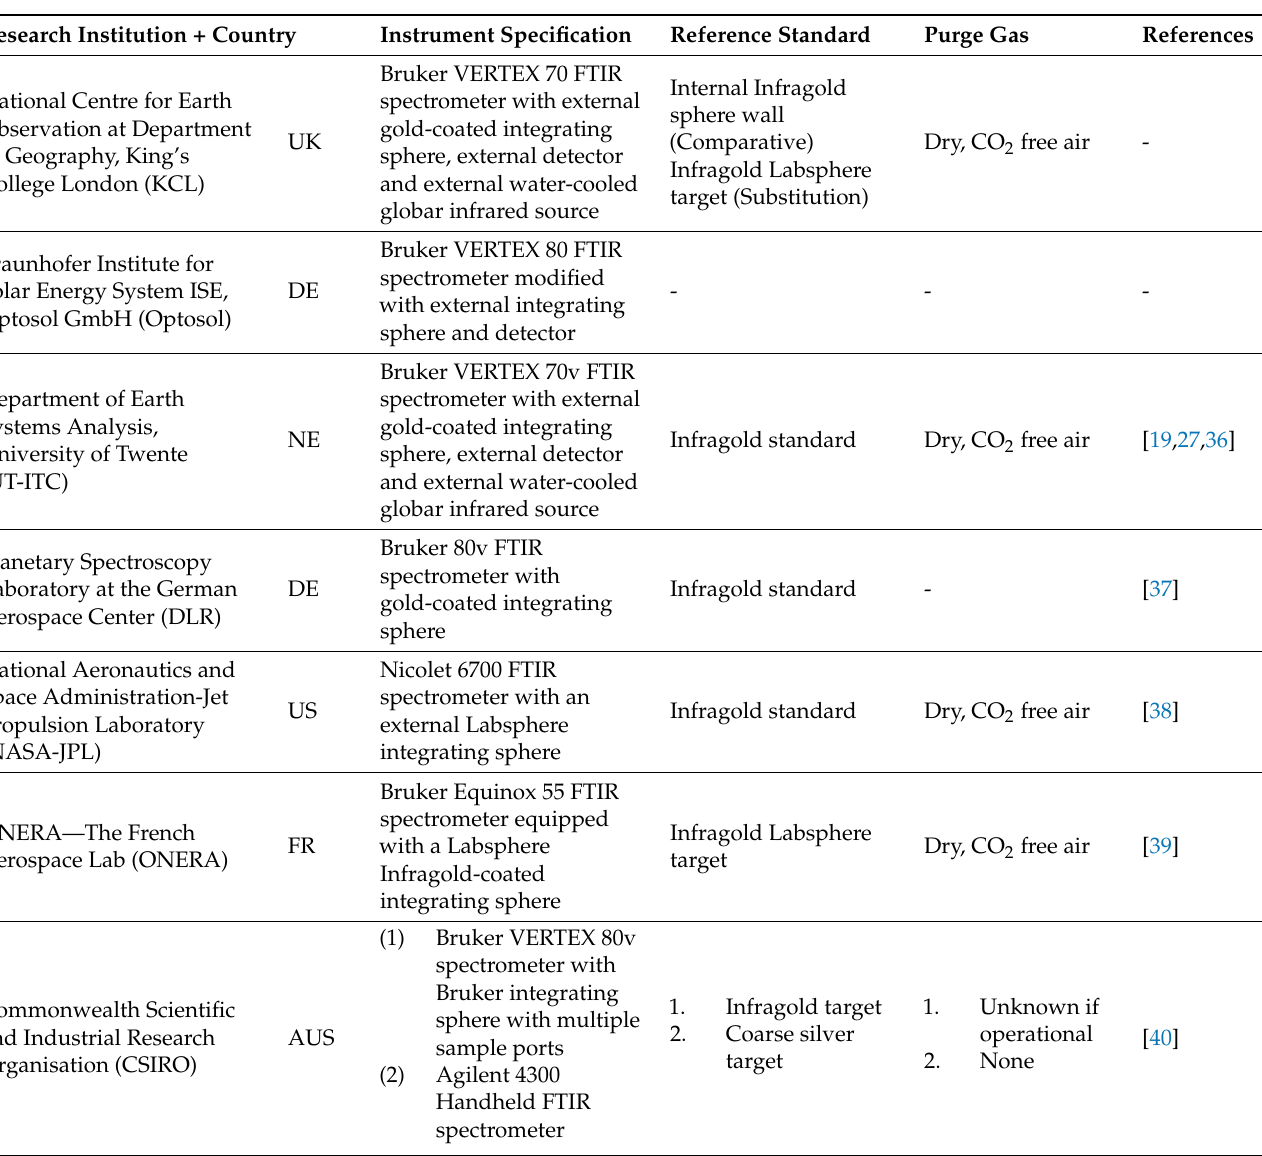
Table 1. An overview of the spectrometer setups of the multiple research organisations participating in this Round Robin surface spectral emissivity measurement intercomparison. The setups are presented here in the order they were used to measure the SE of the selected samples, with information about the instrument, reference standard, gases purging from and references in the literature where available. The names in brackets identify how the laboratories will be referred to